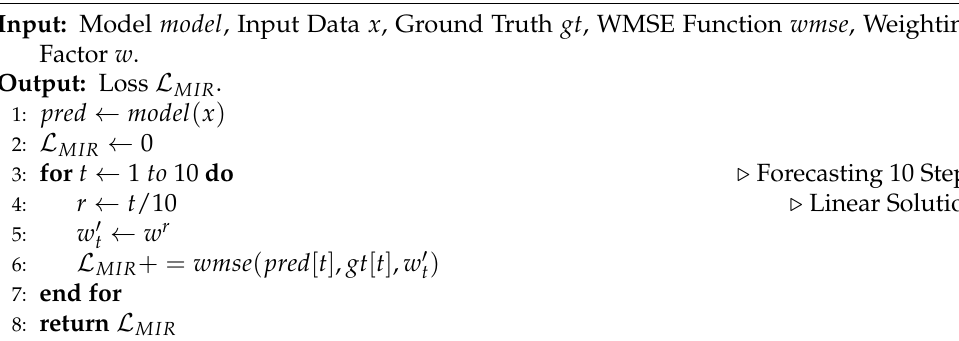
Algorithm 1 MIR Strategy